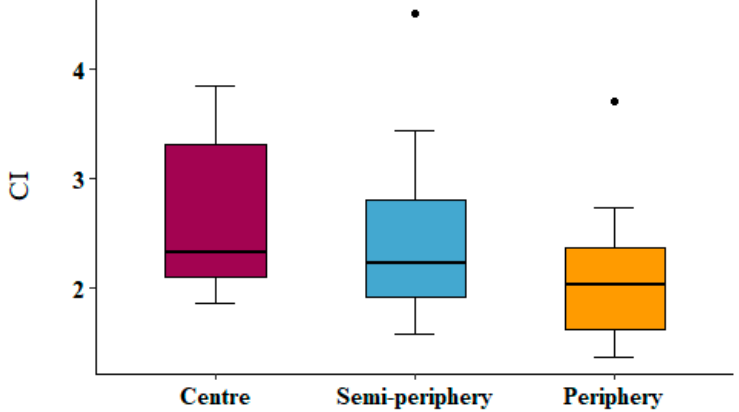
Figure 7. Boxplots showing the value of the contamination index sorted according to concentric belts. Table 2. Pearson correlation matrix between bioaccumulated trace elements and the physiological parameters investigated. * = statistically significant ( p < 0.05) Table 1. Mean (±standard deviation) values ( μ g/g dw) of trace elements accumulated in control and exposed samples (from [28]).